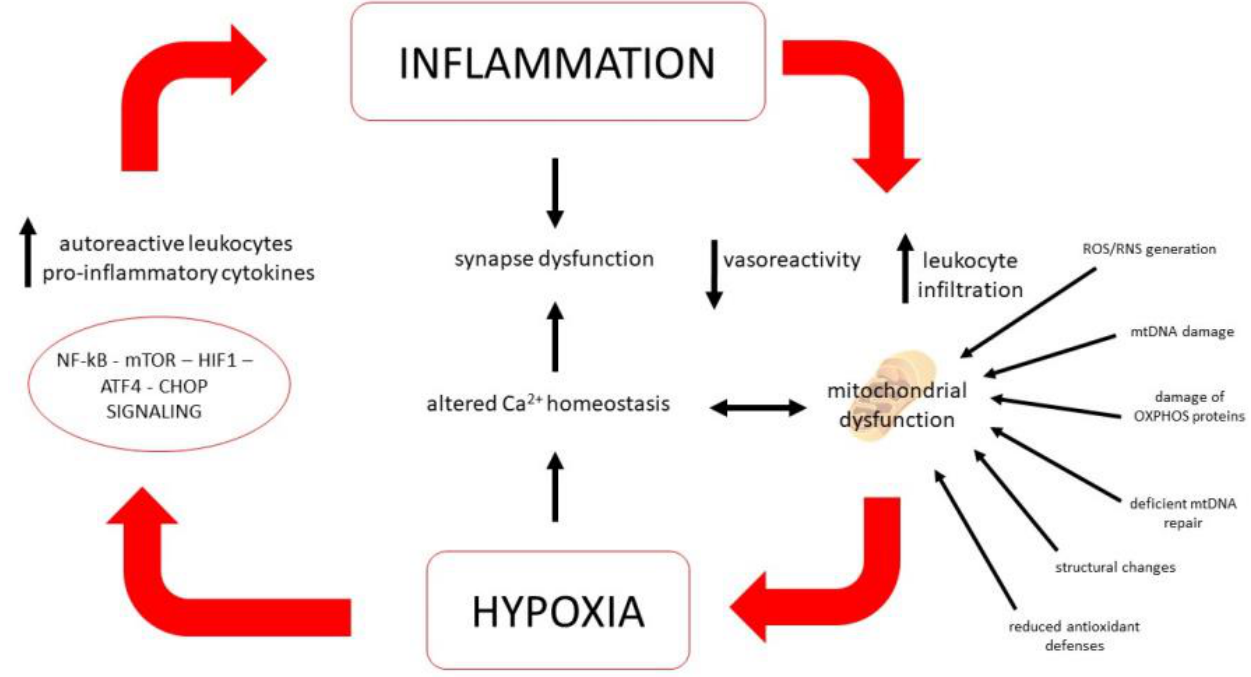
Figure 1. The positive feedback loop of hypoxia and inflammation. The low oxygen presence will lead to the activation of NF- κ B, m-TOR, HIF1, ATF4, CHOP signaling, all regulators of inflammation. In- creased levels of autoreactive leukocytes and pro-inflammatory cytokines can decrease vasoreactivity, and impair mitochondrial function, which could in turn exacerbate